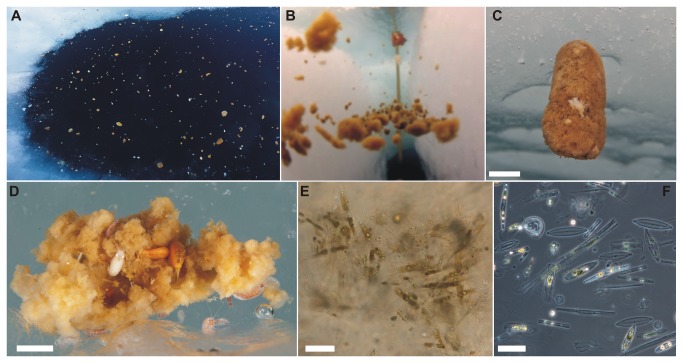
Distribution and composition of ice-algal aggregates.(A) Mass accumulation of aggregates in open melt pond. (B) Accumulation
of aggregates at the interface between melt and seawater layers in a
natural crack through the ice. (C) Composite aggregate floating beneath
sea ice. (D) Porous aggregate colonized by the ice amphipod species
Apherusa glacialis (white) and Onisimus
glacialis (yellow). (E) Light micrograph of pennate
diatoms, mainly Hantzschia weyprechtii, embedded in the
mucous matrix. (F) Light micrograph of mainly empty frustules of
different pennate diatom species. Scale bar = 0.5 m(A), 5 cm (C), 1 cm
(D) and 20 µm (E and F). In panel B the measuring bar (1 m) lowered into
the ice crack in the background serves as a scale for orientation.
Picture A © Jenny E. Ross, pictures C and D © Peter Leopold.